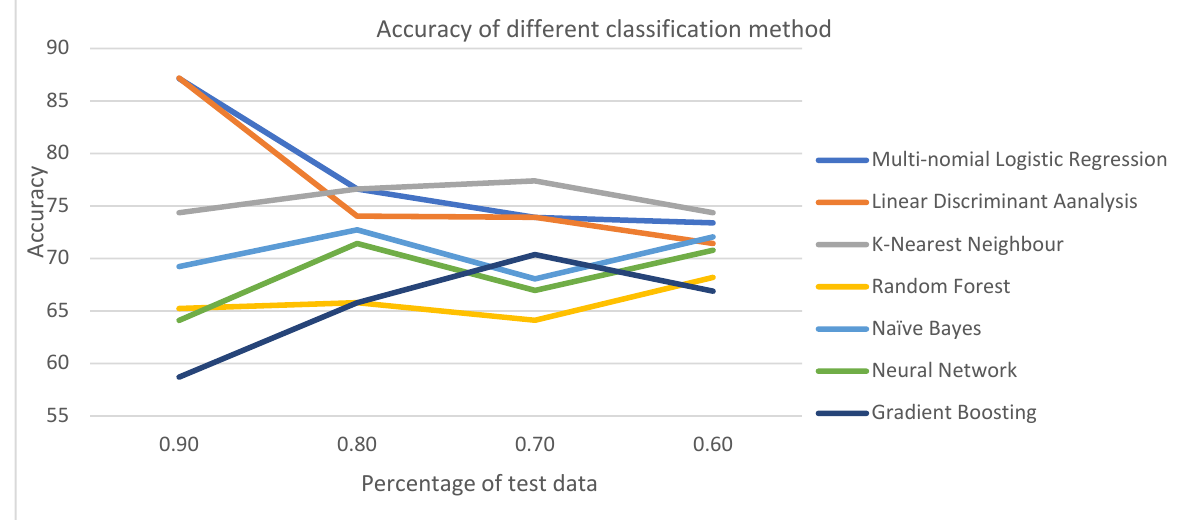
Figure 2. Accuracy of different classification methods for different split ratios.